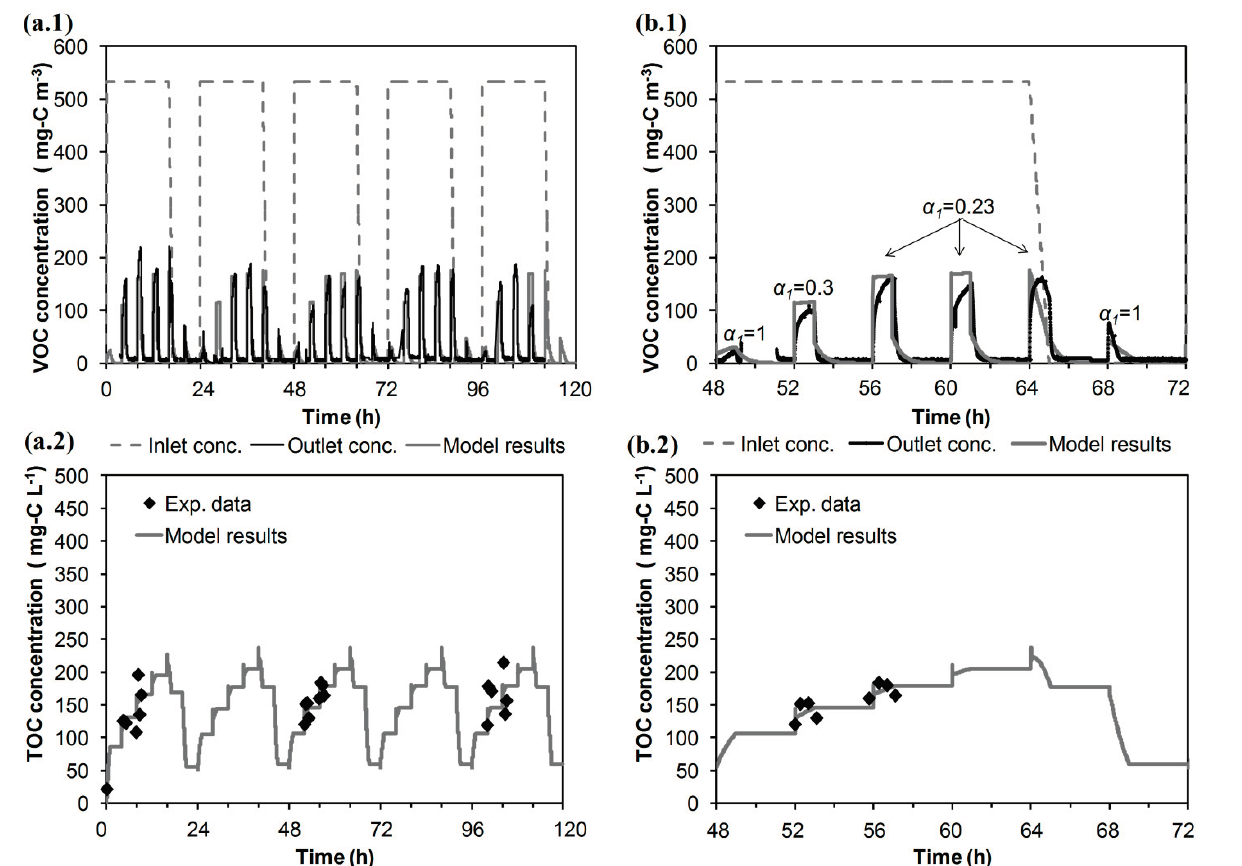
Figure 4. Weekly evolution of experimental data (Run 1) and model predictions for the treatment of isopropanol by a BTF. ( a.1 ) concentration of VOC in the gas phase; ( a.2 ) concentration of the dissolved carbon in the water tank. Wednesday results: ( b.1 ) concentration of VOC in the gas phase; ( b.2 ) concentration of the dissolved carbon in the water tank. Conc. means concentration and Exp. means